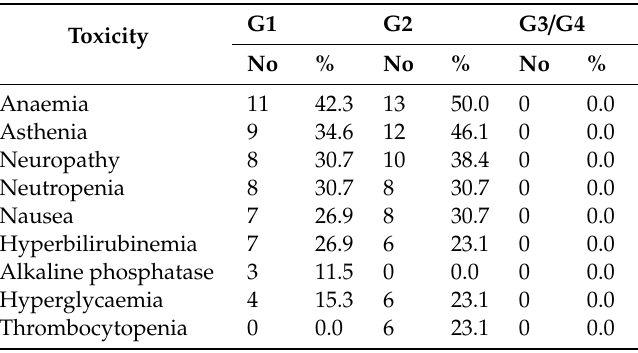
Table 3. Summary of adverse